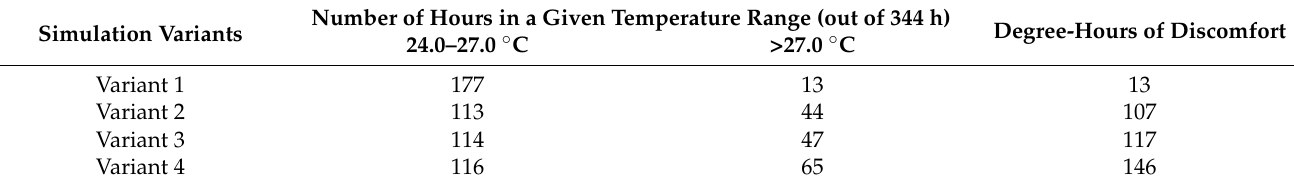
Figure 10. Hourly distribution of indoor air temperature for the reference model variant (number of hours: In the comfort range—green, above the comfort range—red, below the comfort range—black). Table 4. Number of hours of indoor air temperature within the thermal comfort range and outside this range for the two-month analysis period.